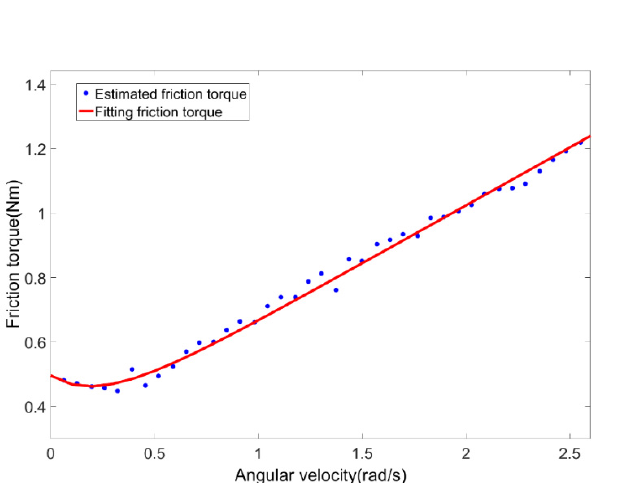
Figure 6. Friction torque with respect to harmonic angular velocity. In the low speed area (w < 0.3 rad/s), the friction torque will decrease with the increase of speed and accompany with serious nonlinearity. It is due to the fact that the maximum static friction torque is usually greater than the sliding friction torque. After reaching a certain speed (w > 0.3 rad/s), viscous friction plays a dominant role, and the friction torque increases approximately linearly with the angular velocity.